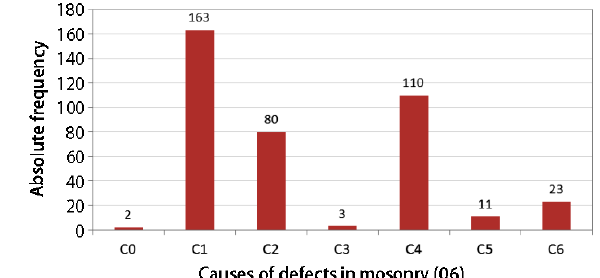
Fig. 14. Absolute frequency of defects in masonry (06)